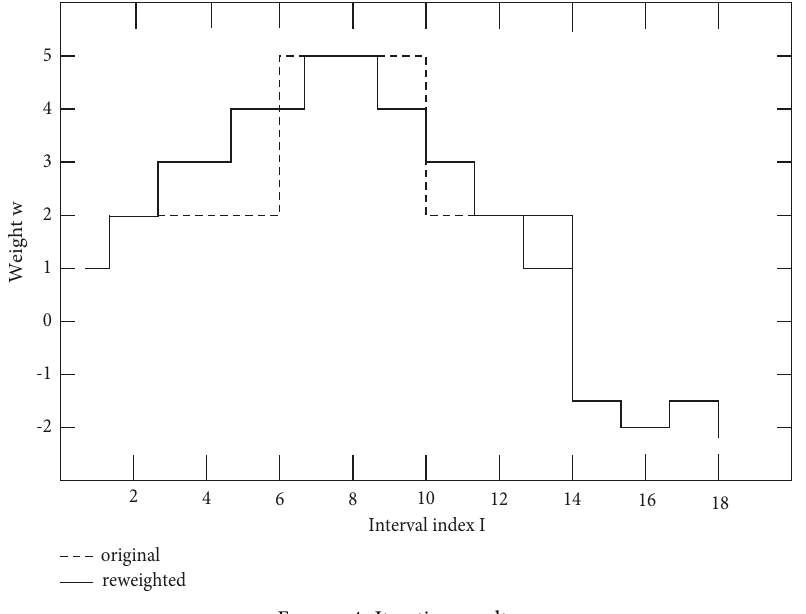
Figure 4: Iterative